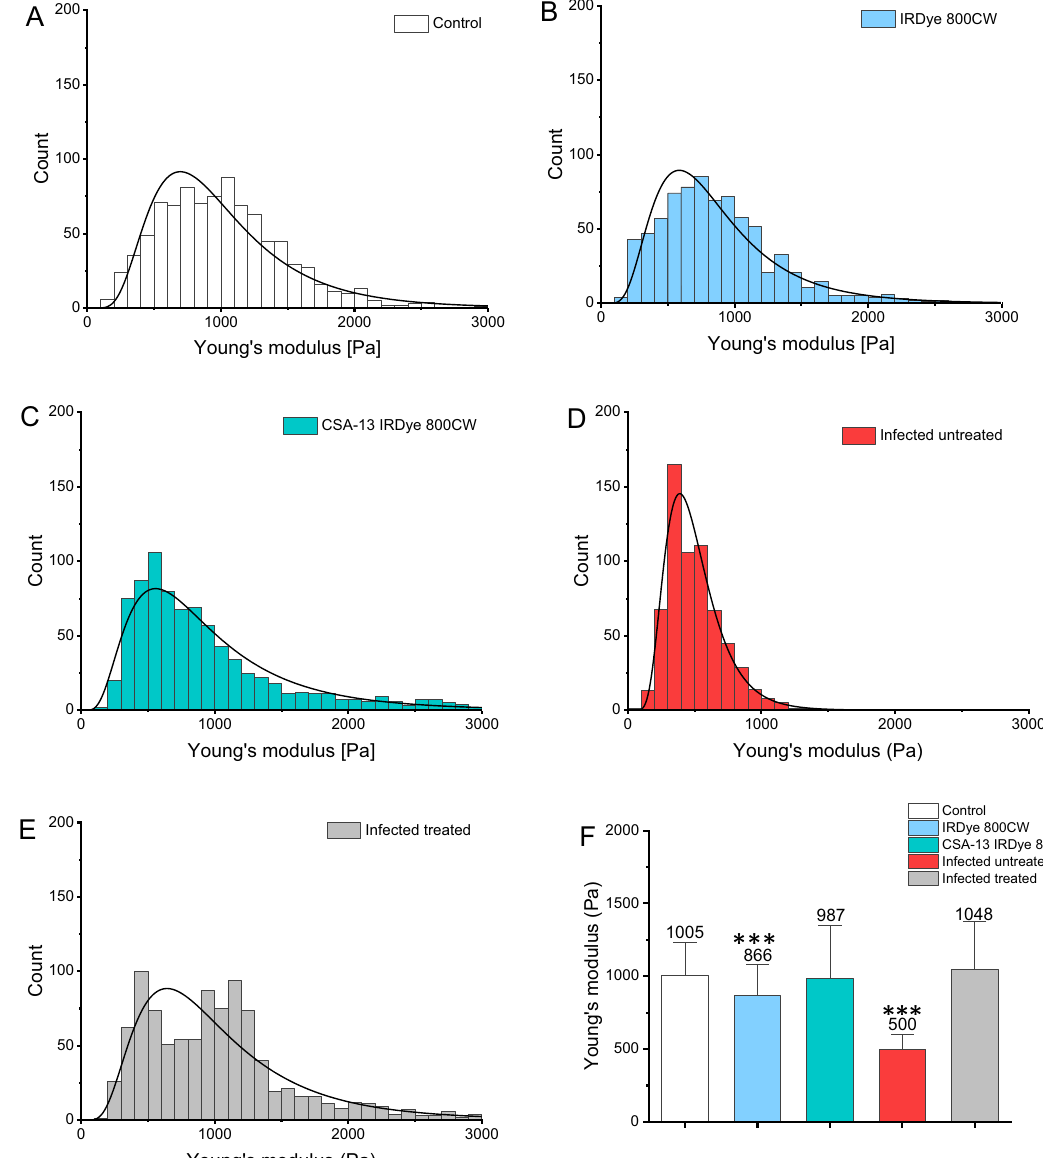
Figure 5. The Young’s modulus values measured for each bladder samples collected from healthy animals, both untreated ( A ) and treated with IRDye800CW ( B ) or CSA-13-IRDye800CW ( C ), as well as E. coli Xen14- infected animals, both untreated ( D ) and treated ( E ) with CSA-13-IRDye800CW, with the logarithm of the normal distribution of the adjusted probability function density. The mean values of Young’s modulus ± standard deviation ( F